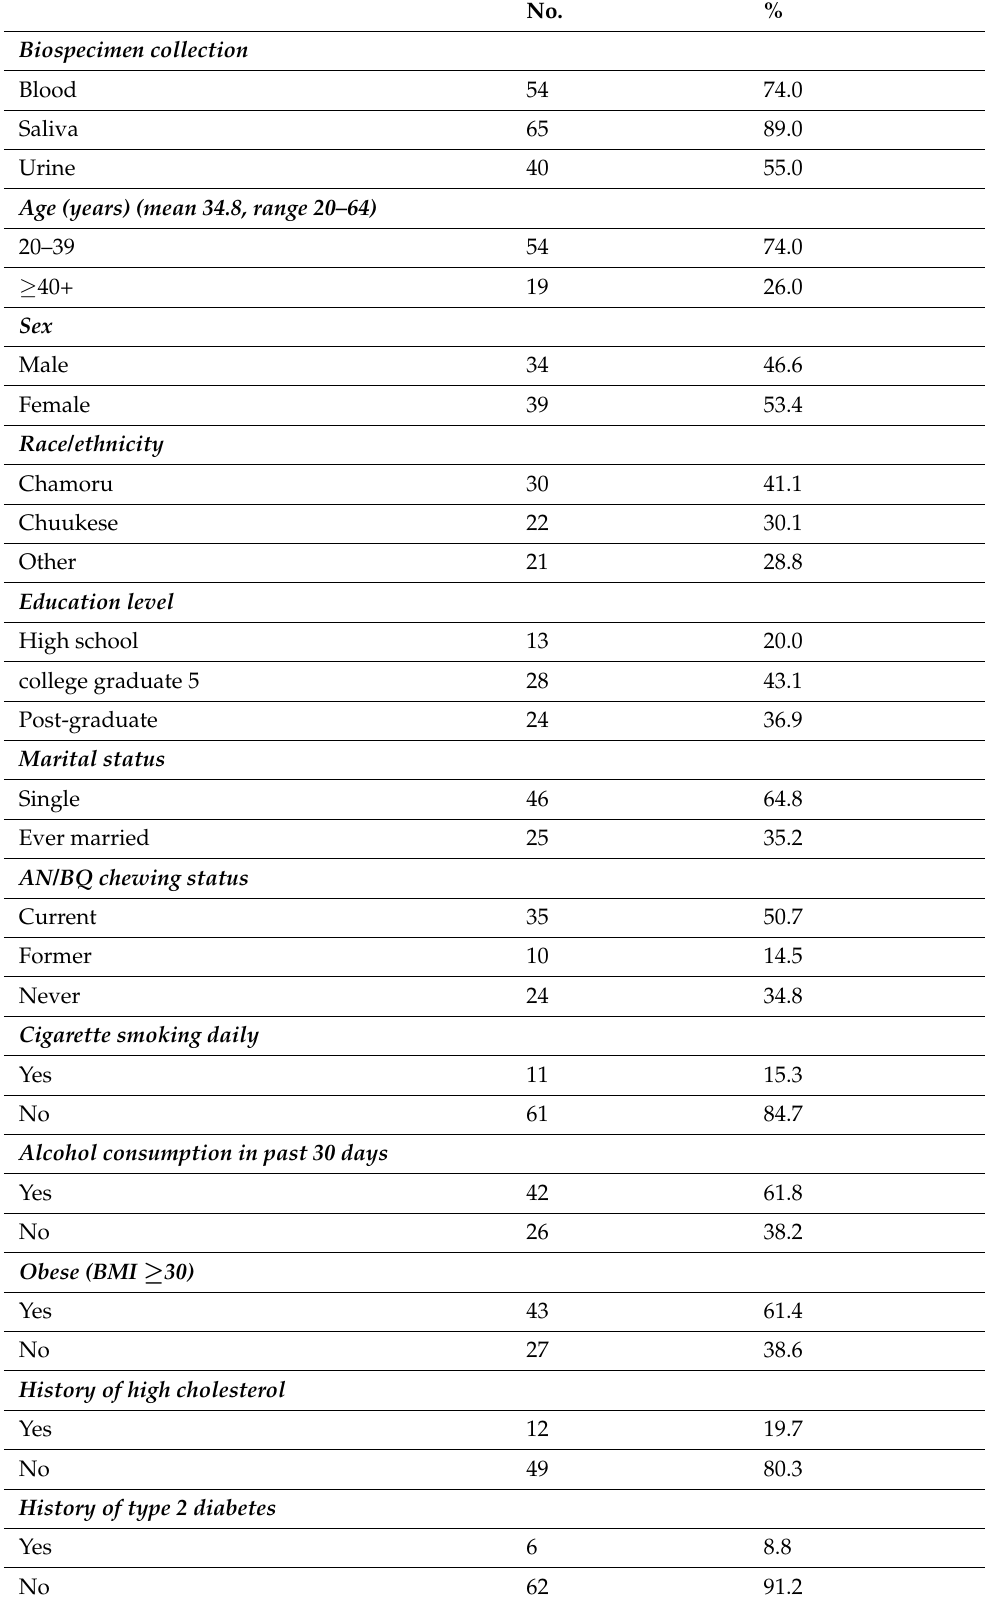
Table 1. Study Population Characteristics ( n =